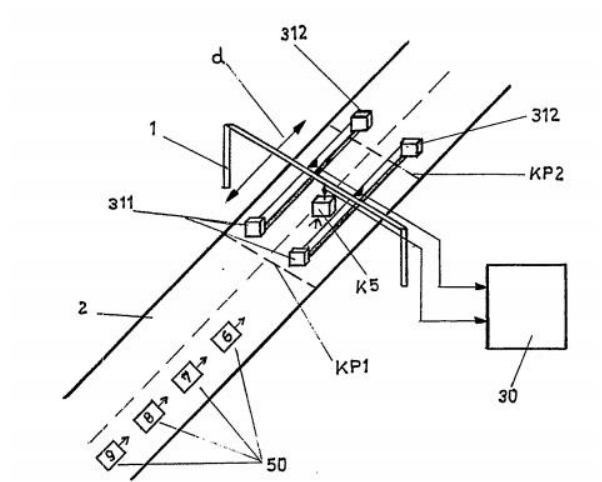
Fig. 2. Operating principle of the device described in Patent DE4235235(A1) titled „Continuous determination of traffic-generated pollution – employing vehicle-mounted digital signal transmitters which, on passing reference station, identify vehicle to enable pollution assessment”